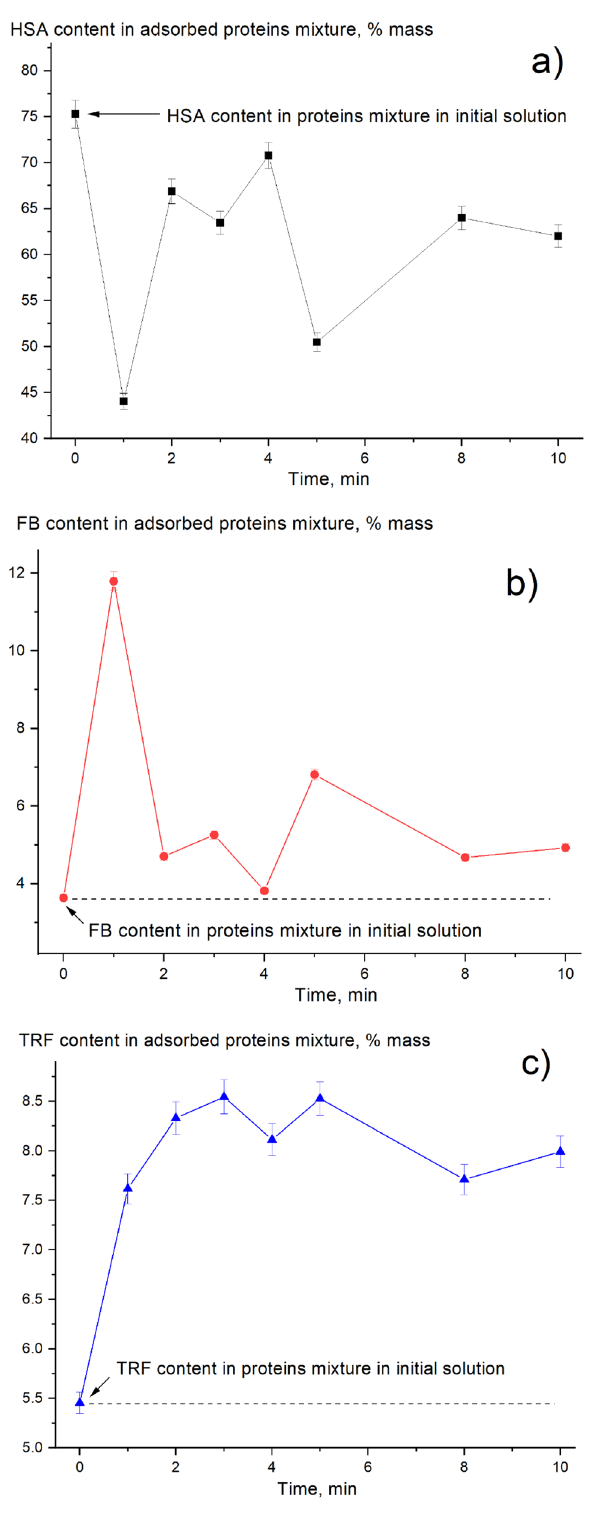
Figure 13. Change in the protein content in the adsorbed protein mixture with time: ( a ) HSA; ( b ) FB; ( c )